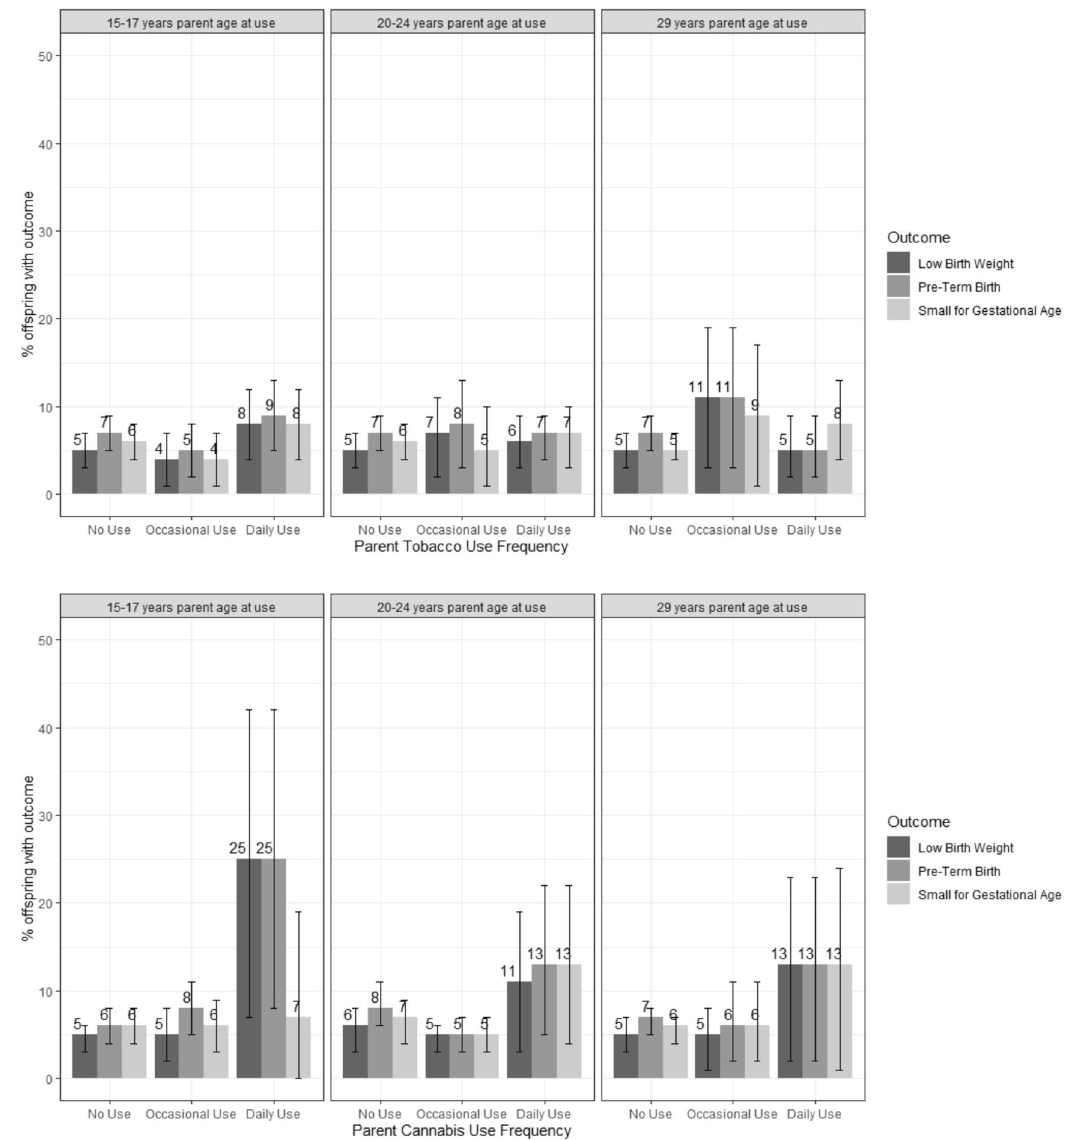
Figure 2. Estimate proportion of children with each birth outcome by frequency of parent substance use in 1030 children born to 665 parents In the VIHCS study (imputed